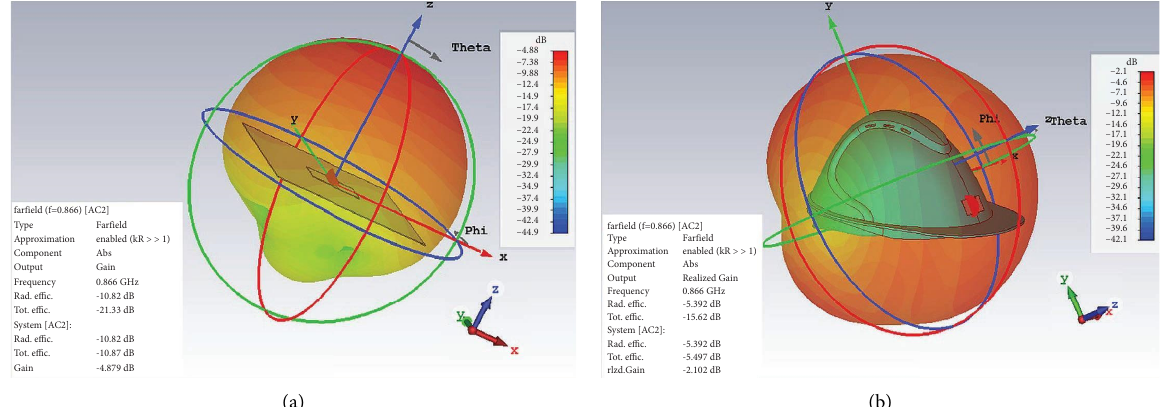
Figure 18: 3D radiation patterns for the designed tag on the (a) metal sheet and (b)